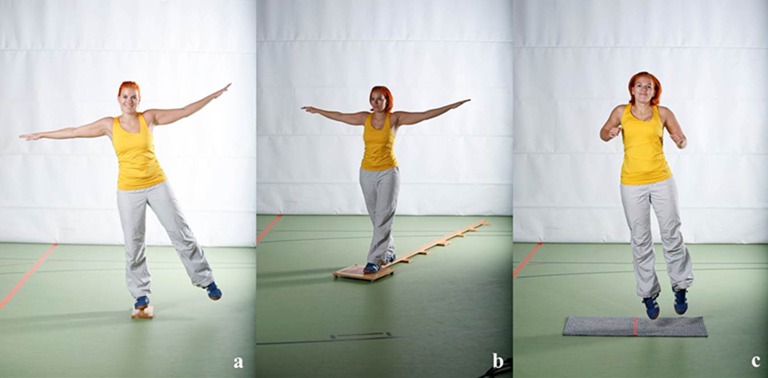
Gross motor coordination tasks (a, one-leg stand; b, balancing backwards; c, jumping side-to-side).